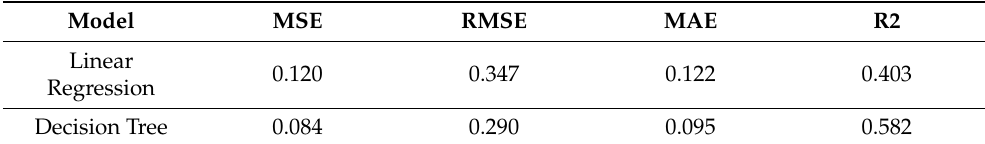
Table 6. Model test and results.